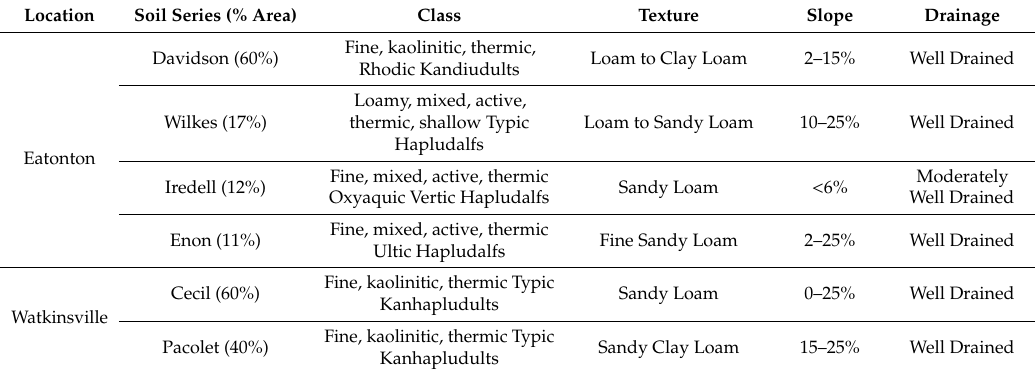
Table 2. Soil classifications of Eatonton and Watkinsville study